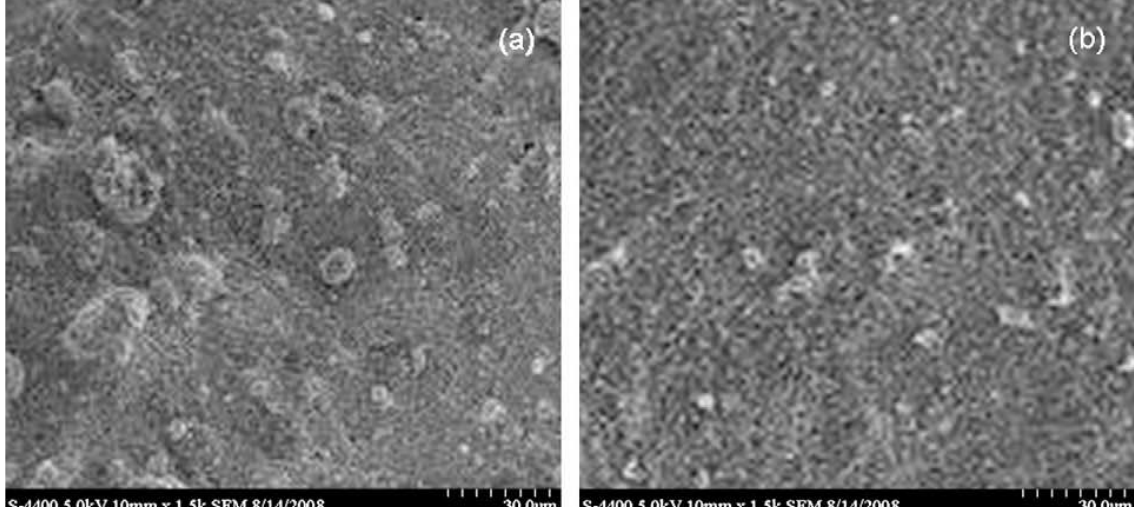
Figure 11. SEM images of PEMFC anodes prepared by ( a ) the galvanostatic pulse method without ultrasound and ( b ) the sono-galvanostatic pulse method (20 kHz, 40 W·cm −2 ) [33].